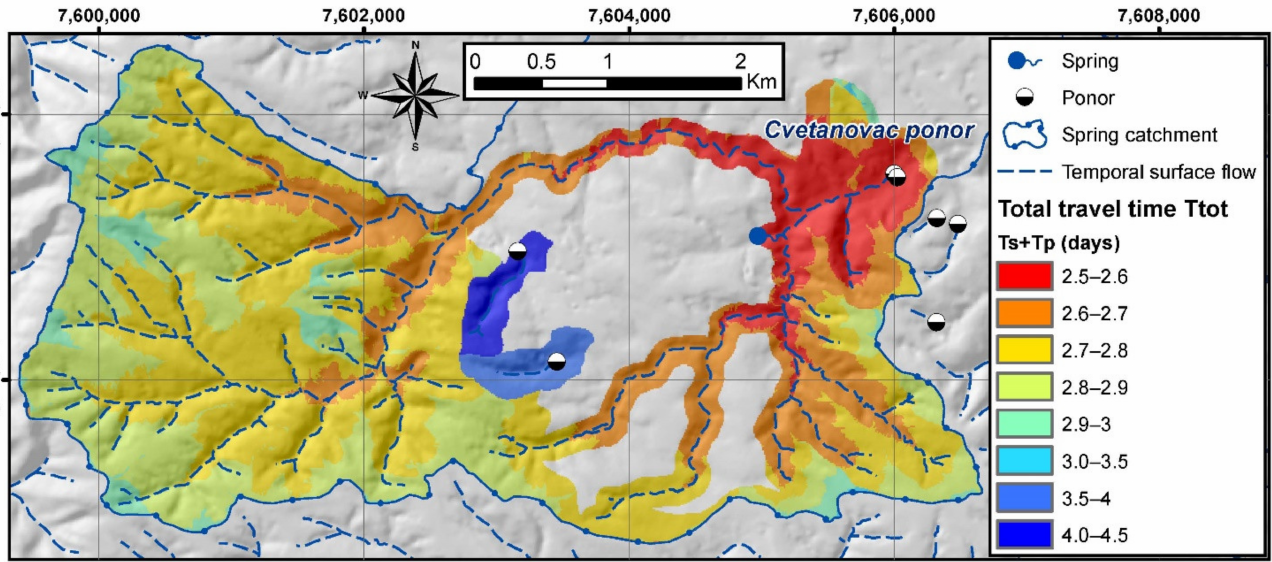
Figure 7. Total travel time (t tot ) in the ponor’s catchment